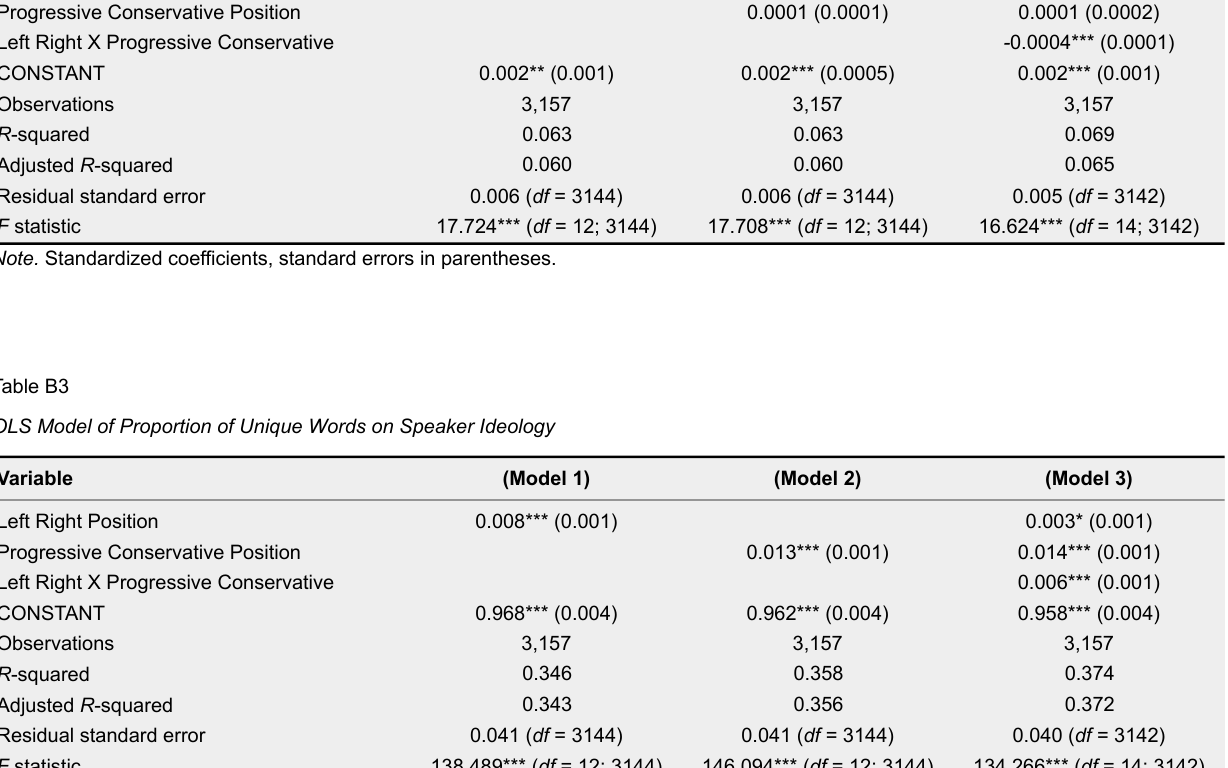
Note. Standardized coefficients, standard errors in